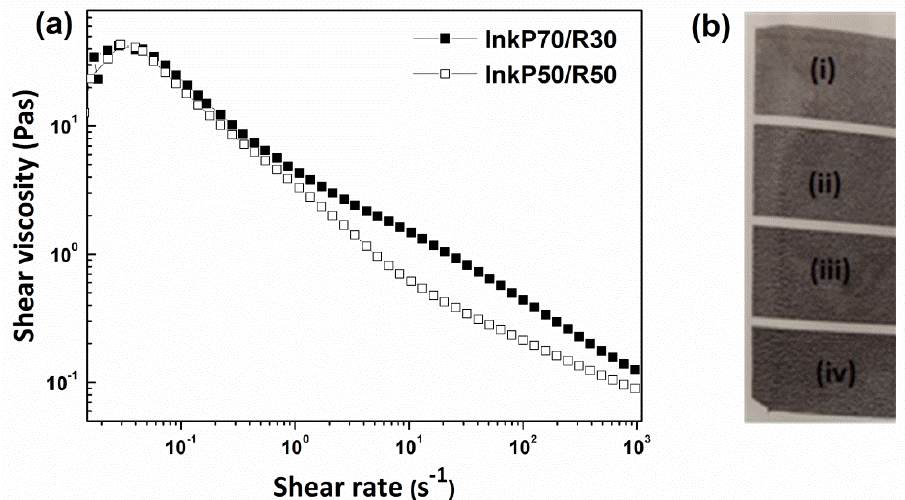
Figure 9. ( a ) Viscosity of both inks (Ink P70/R30 and Ink P50/R50 ) as a function of shear rate with the ratio of pigment solids/resin solids as a parameter; ( b ) gravure-printed item with four zones (i – iv) of different thicknesses of the ink layer (thickness increases from i to iv).